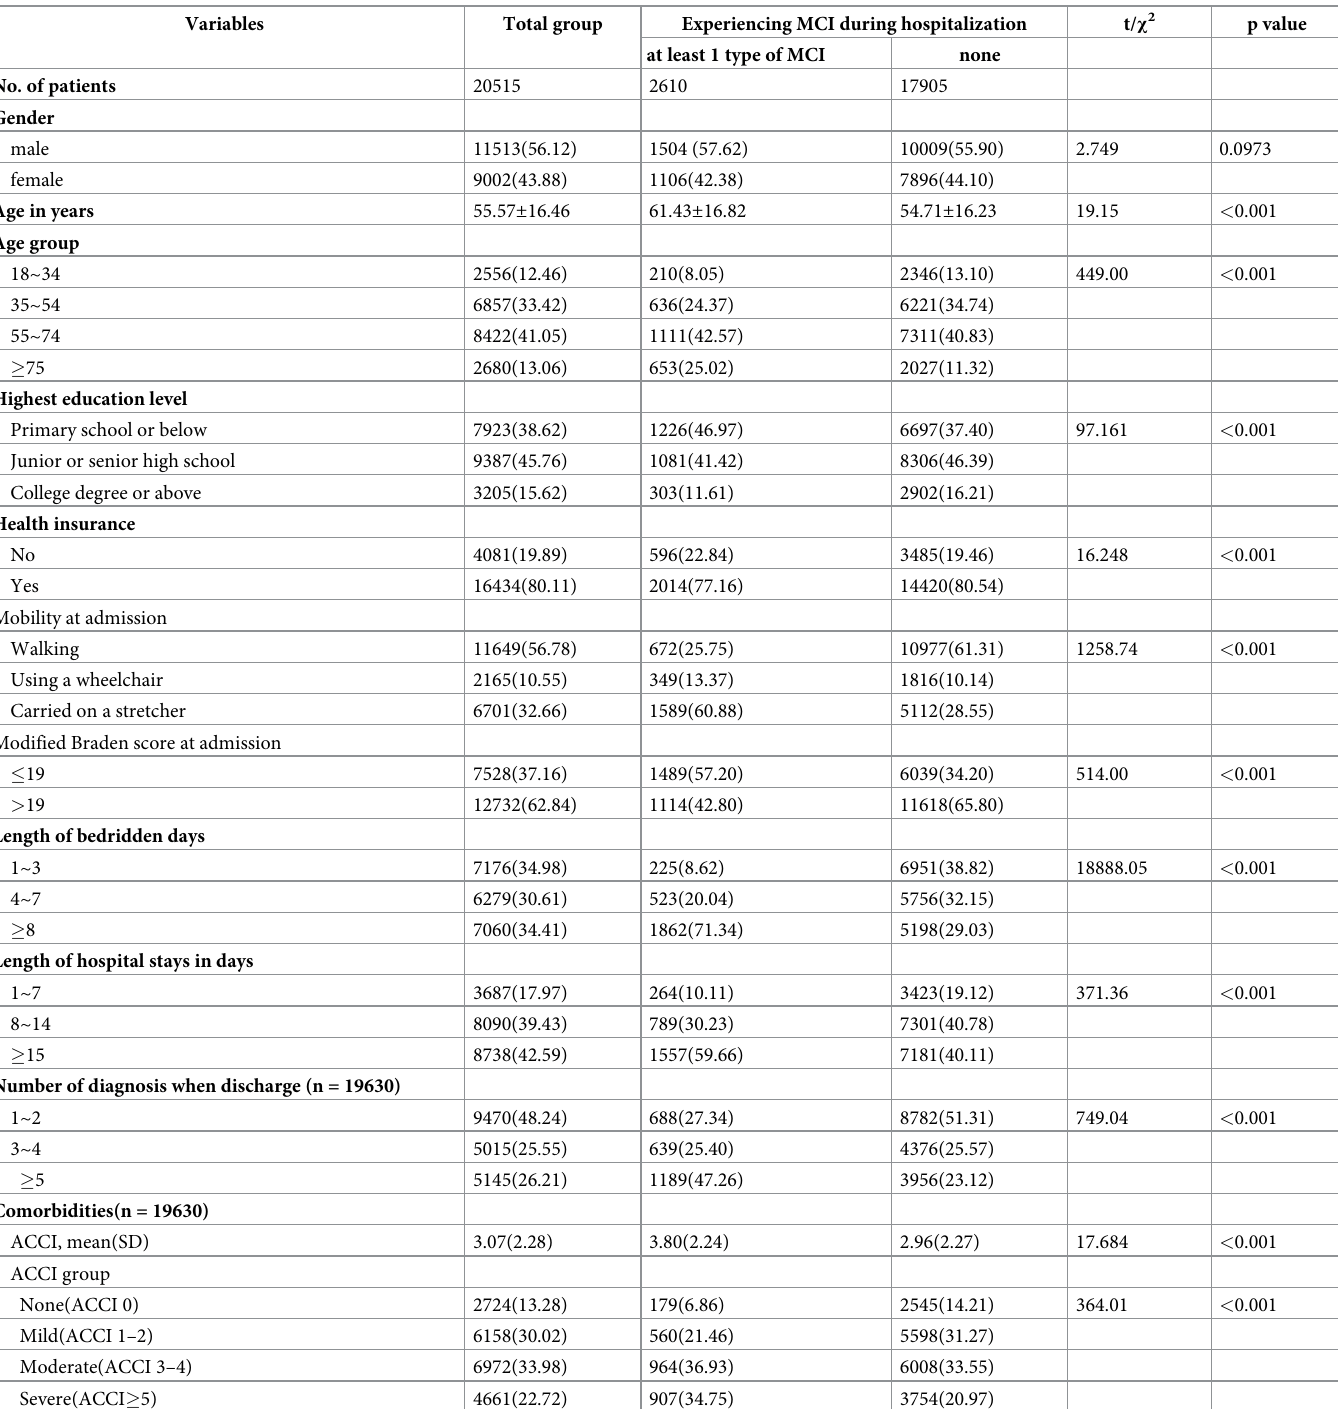
Table 1. Baseline characteristics of patients with MCI and patients without MCI (n =